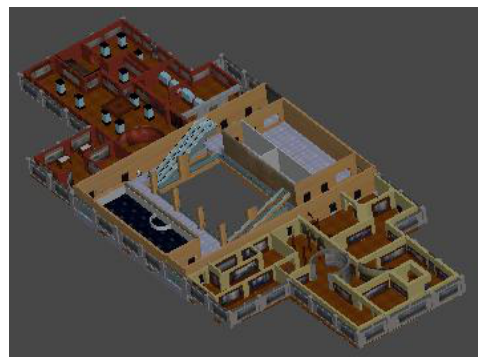
Figure 2. Geometric model of the building